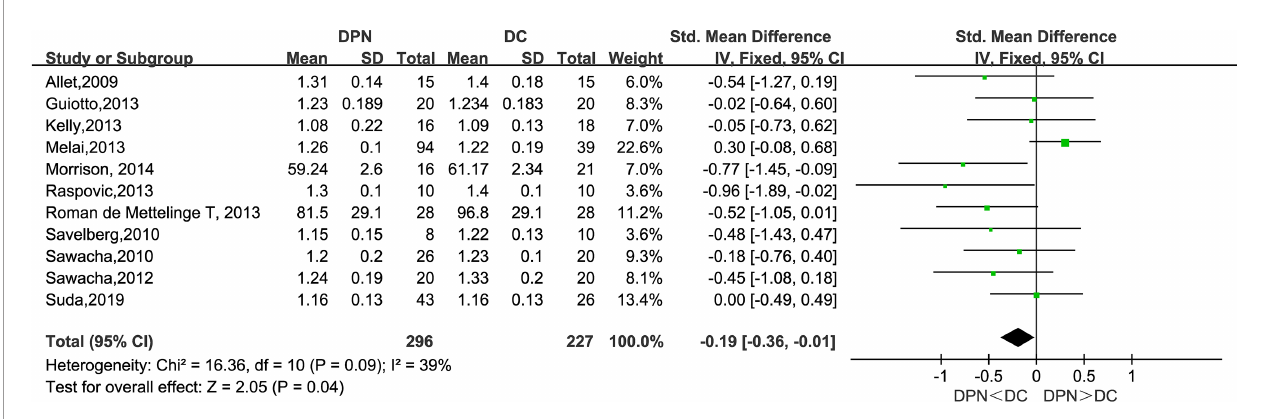
FIGURE 4 | Forest plot of stride length(m).